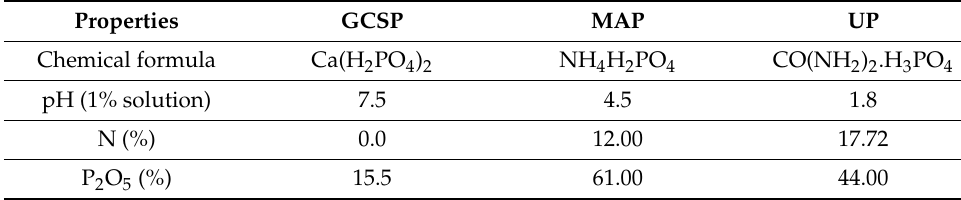
Table 3. Chemical analysis of phosphorus fertilizers applied in this study.